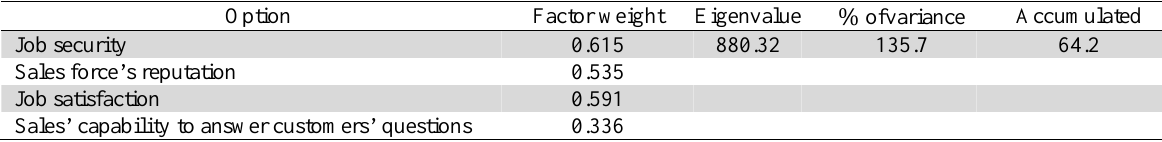
The summary of factors associated with sales force’s motivation